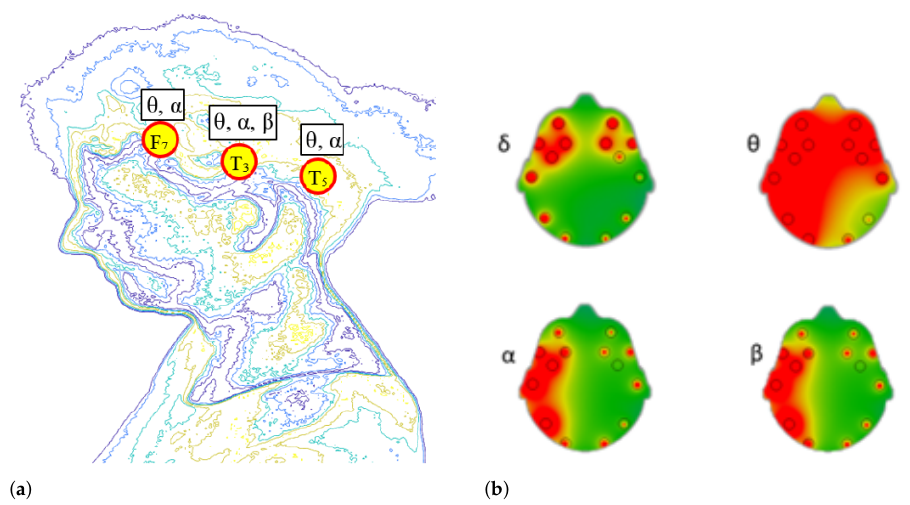
experiments but to varying degrees.